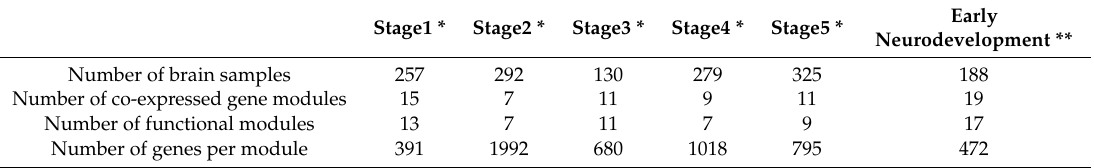
Table 1. Summary of weighted gene correlation network analysis (WGCNA).